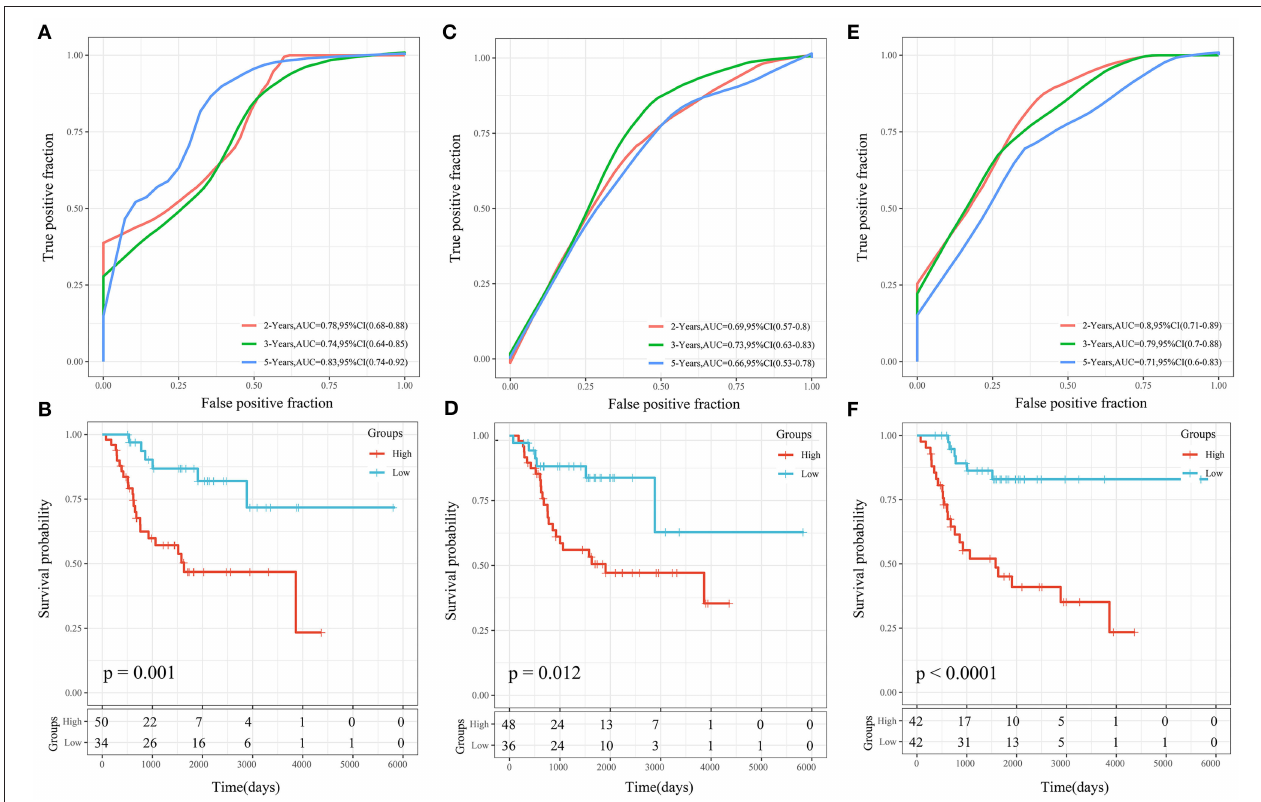
FIGURE 12 | (A,B) ROC and KM curves of the overall survival of the high- and low-risk samples using the 19-gene signature risk model (Goh). (C,D) ROC and KM curves of the overall survival of the high- and low-risk samples using the 8-gene signature risk model (Zhang). (E,F) ROC and KM curves of the overall survival of the high- and low-risk samples using the 3-gene signature risk model(Shi).